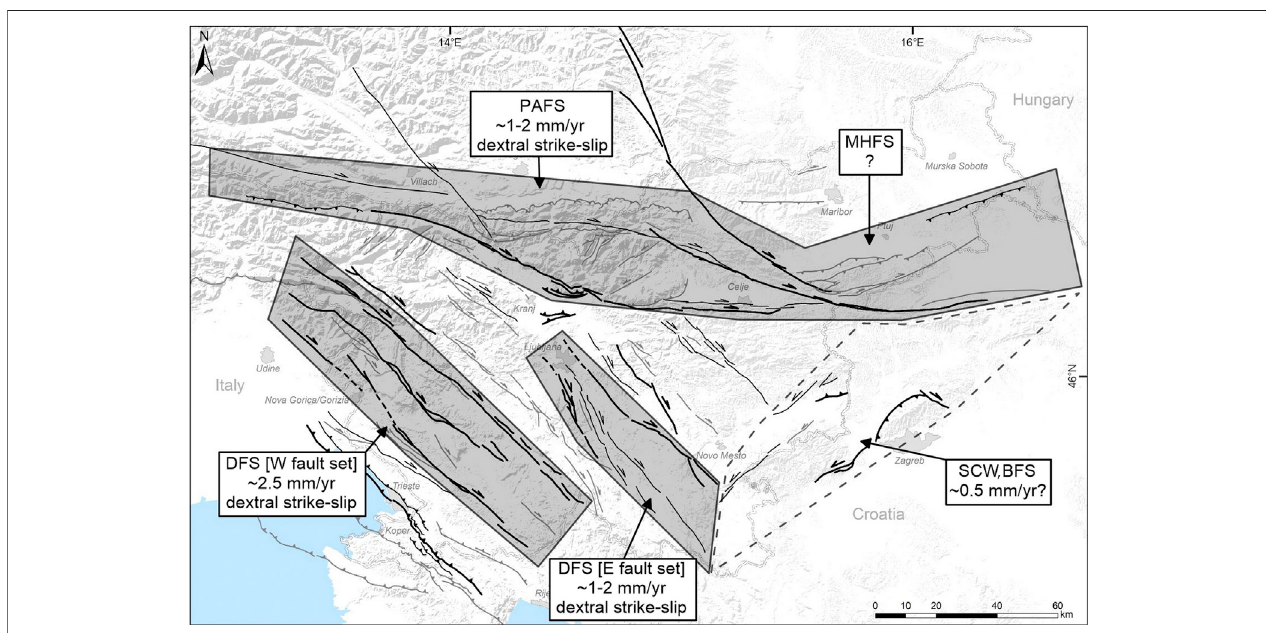
FIGURE 11 | Approximate cumulative horizontal displacement/slip rates across the most active fault systems in Slovenia. The Dinaric fault system contains two spatially well-constrained fault sets which concentrate most of the displacement.